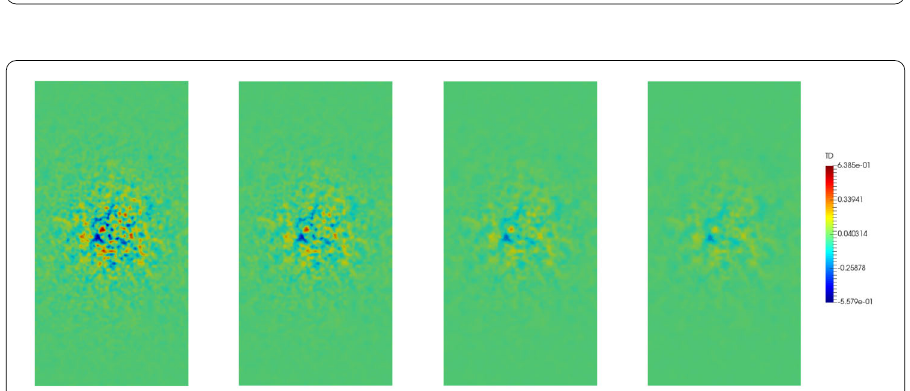
Figure 6 Thermograms with ω = 2 Hz. Left: amplitude of the temperature | T front | . Right: difference between thermograms corresponding to a healthy plate and a faulty one. At high frequencies the box defect, which is the shallower one, is barely visible